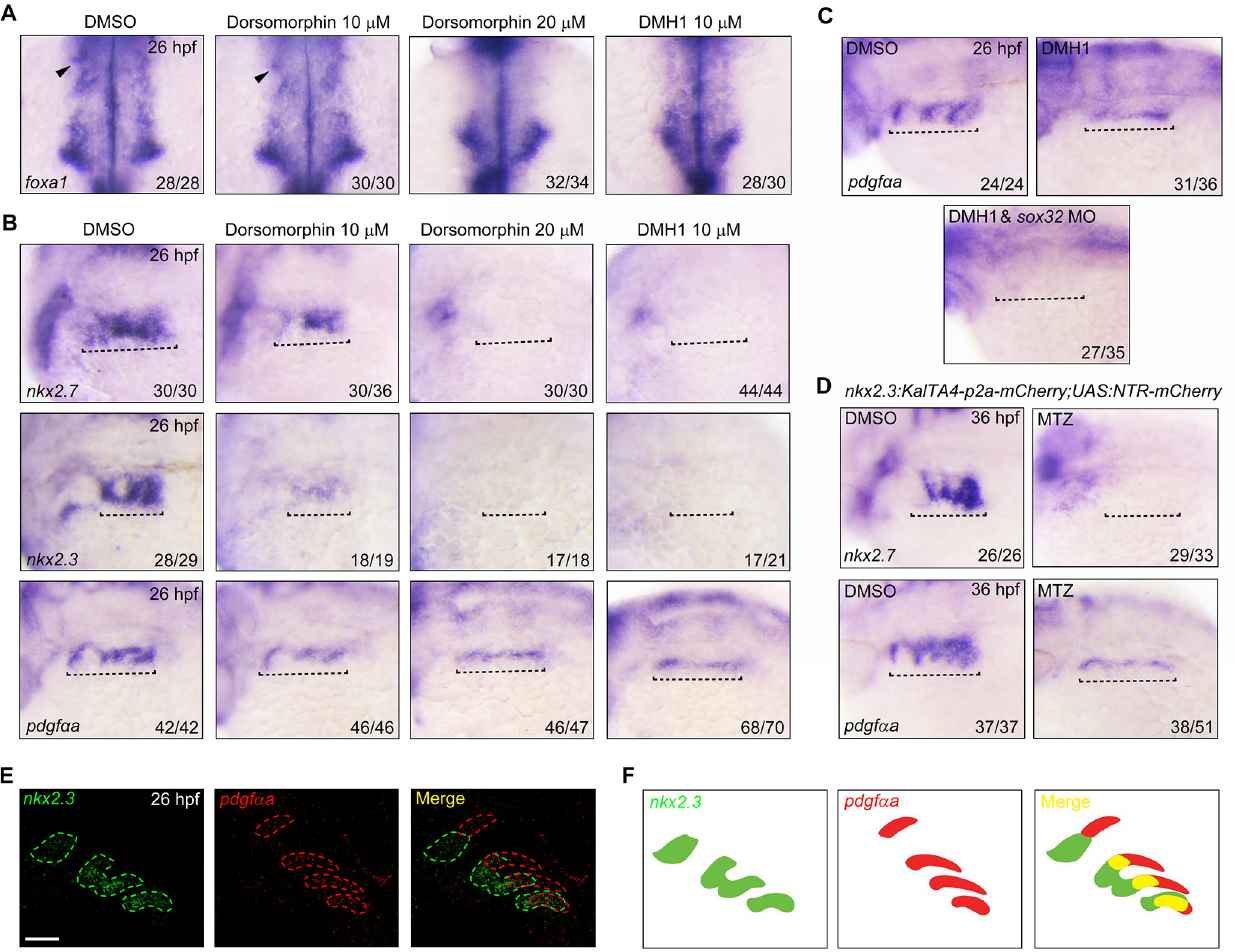
Fig 4. BMP signal inhibition results in a severe loss of nkx2 . 3 + pouch epithelium. ( A-B ) In situ hybridization analysis of the expression of foxa1 (A), nkx2 . 7 , nkx2 . 3 , and pdgf α a (B) at 26 hpf in embryos treated with different dose of BMP inhibitors from bud stage to the 17-somite stage. Black arrowheads in (A) indicate the first pouch. Black dotted lines in (B) highlight the pharyngeal region. (C) The expression of pdgf α a in DMH1-treated embryos injected with or without sox32 MO. Note that when DMH1-treated embryos were injected with 8 ng sox32 MO, the expression of pdgf α a was abolished. (D) The expression of nkx2 . 7 and pdgf α a in nkx2 . 3 + pouch progenitor-depleted embryos. Tg(nkx2 . 3 : KalTA4-p2a-mCherry;UAS : NTR-mCherry) embryos were treated with 50 mM MTZ from the 32-cell stage to the 17-somite stage, and then harvested for i n situ hybridization at 36 hpf. ( E-F ) Double-fluorescence in situ hybridizations for nkx2 . 3 and pdgf α a at 26 hpf, In situ hybridization analysis of pdgf α a at 26 hpf. Note that nkx2 . 3 (green) and pdgf α a (red) display nested expression patterns along the dorsal-ventral axis of the pouch epithelium. Schematic expression of nkx2 . 3 and pdgf α a was shown in (F). Scale bar, 50 μ m.